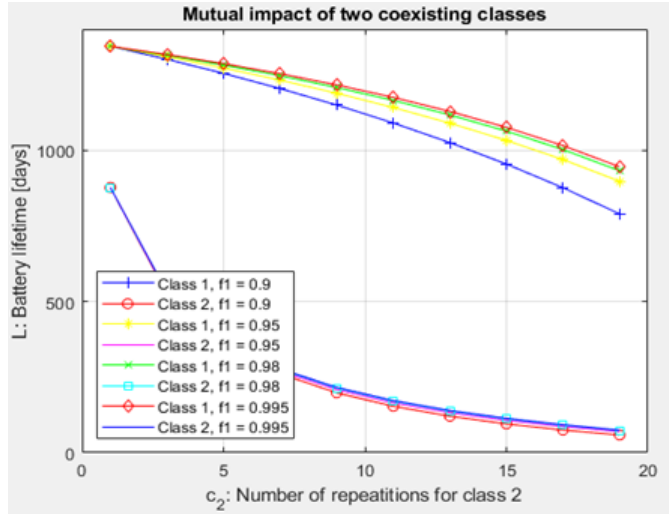
Figure 19. Expected lifetime of devices batteries with respect to the number of